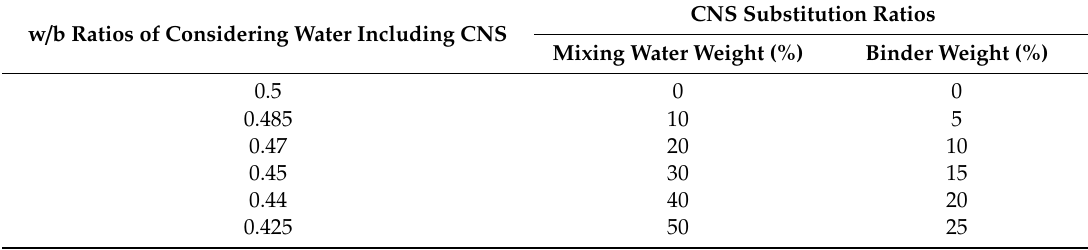
CNS Substitution